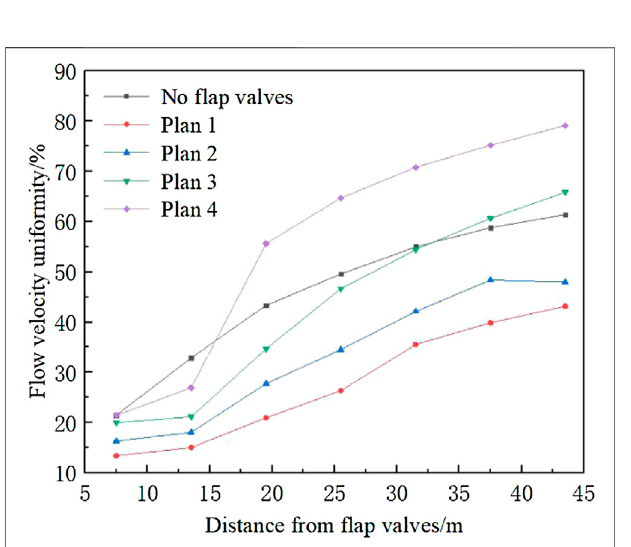
FIGURE 14 | Hydraulic loss under different fl ow